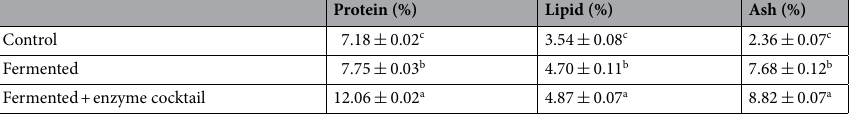
Table 2. Protein, lipid and ash contents of the fermented samples. Different letters in the same column indicate significant differences (p <